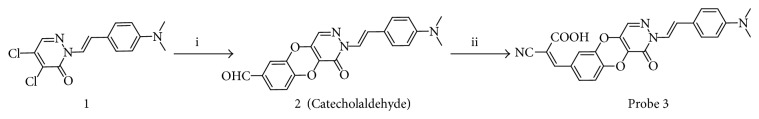
Reaction scheme for the synthesis of the pyridazine-based probe (3). (i) DMF, 3,4-dihydroxybenzaldehyde, K2CO3, refluxed for 24 h; (ii) CHCl3, cyanoacetic acid, piperidine, refluxed for 15 h.